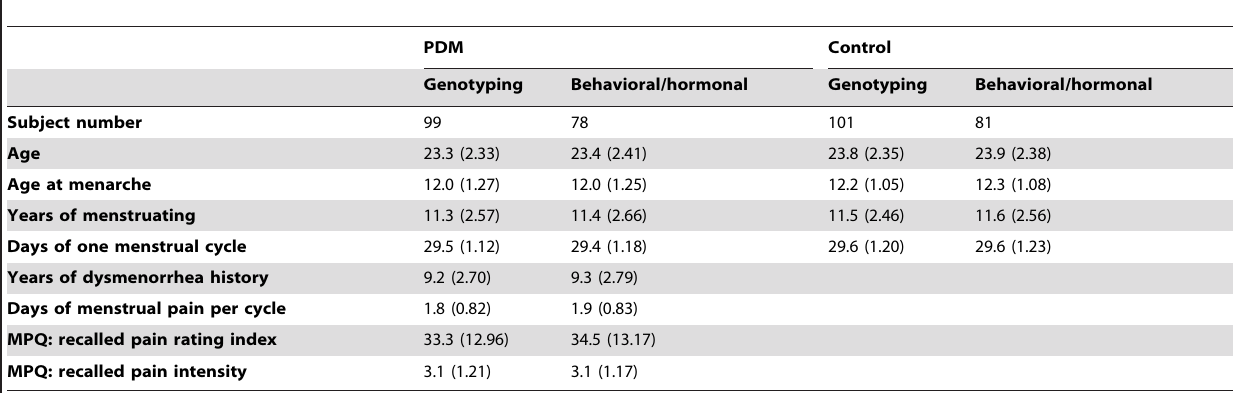
Table 1. Demographic data of the original genotyping groups and the behavioral/hormonal